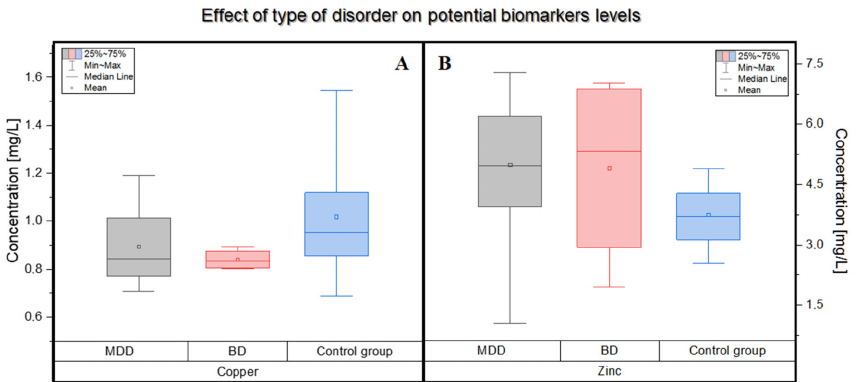
Figure 2. Differences in the concentration of copper and zinc in the blood of patients suffering from BD (pink, n = 4) and MDD (grey, n = 11) compared to the control group (blue, n = 15). The mean (circle), median (line), percentile 25, 75 (boxes), and minimum and maximum value (whiskers) are shown in both figures. ( A ) Box plot showing the influence of type of disease or no disease on the concentration of copper. ( B ) Box plot showing the influence of the type of disease or no disease on the concentration of zinc.